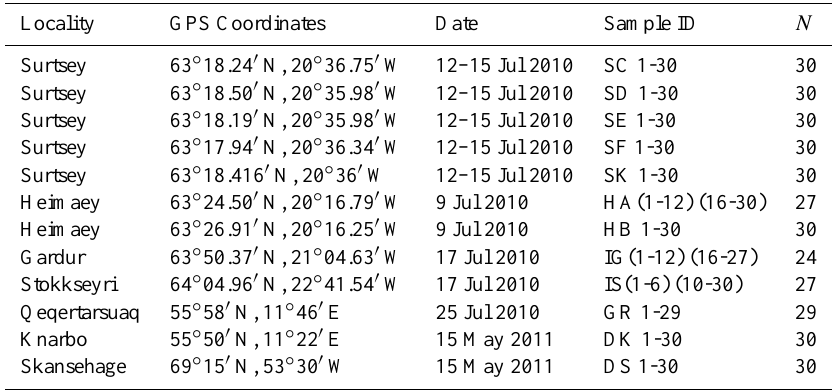
Table 1. Sampling locations, GPS coordinates, collection dates, IDs and number of samples. Locality